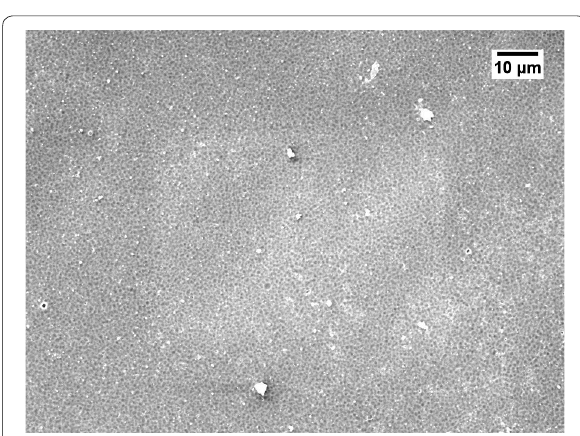
Fig. 1 SEM image of PEI membrane made by NMP and 23 wt%